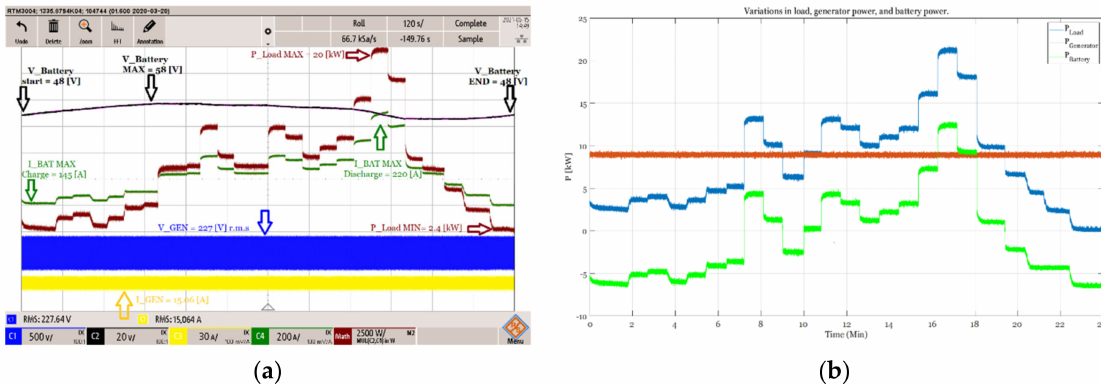
Figure 13. Experimental results based on the new sizing procedure: ( a ) system voltage currents and power on oscilloscope. ( b ) MATLAB processed power system balancing (blue–load, green–battery, and red–generator).